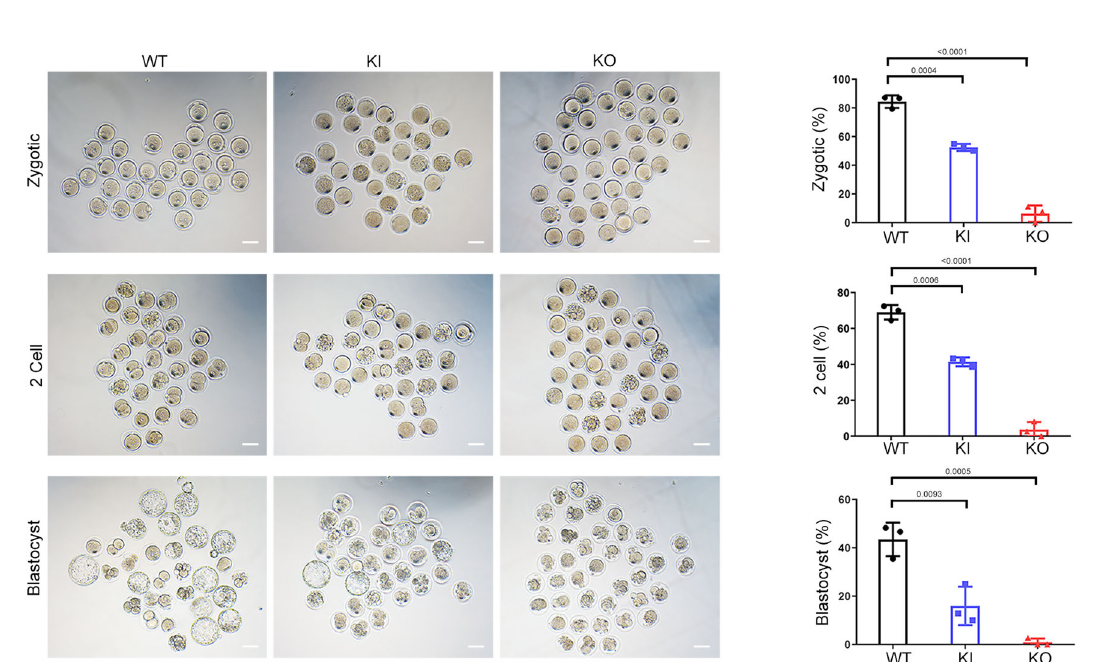
Fig. 8 Poor prognosis after ICSI treatment using the sperm from homozygous Cep128 KO and KI mice. We observed signi fi cantly decreased percentages of one-cell zygotes, two-cell embryos, and blastocysts in the homozygous KI group, and the KO group showed almost total fertilization failure ( n = 3 biologically independent WT mice, KI mice or KO mice; scale bars, 100 μ m; two-sided Student ’ s t test; error bars, mean ± SEM). The p values are indicated in the graphs. Source data are provided as a Source Data fi